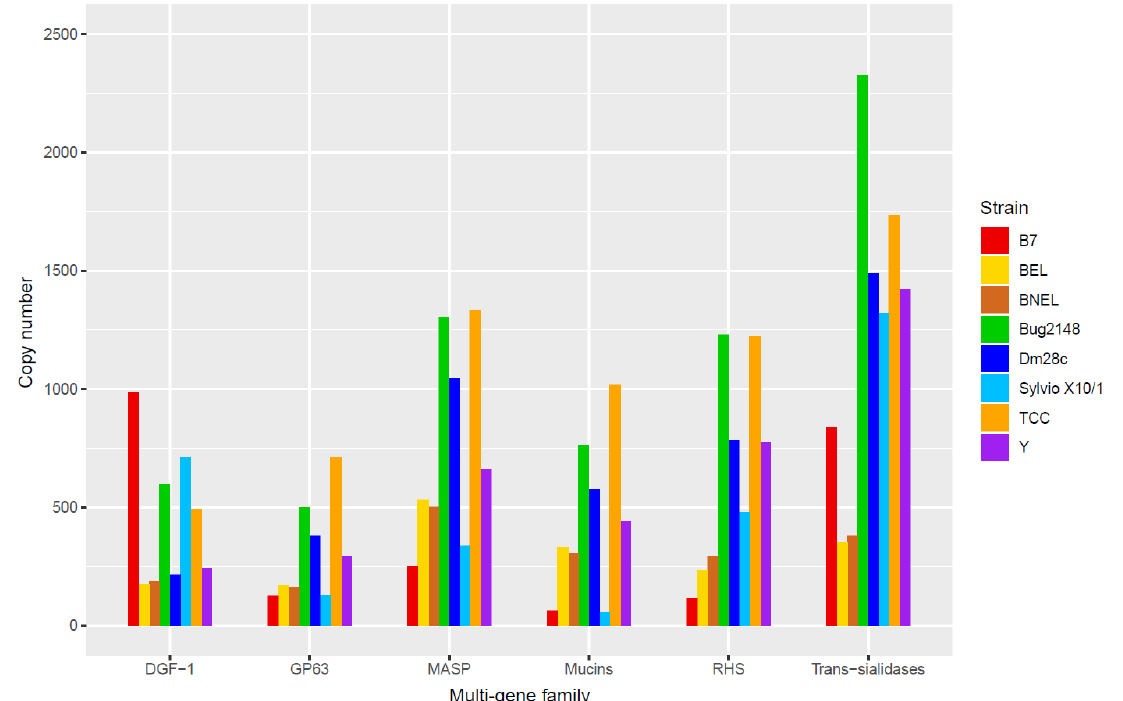
Figure 3. Genome copy number of the most abundant multi-gene families of T. cruzi and the B7 strain of T. cruzi marinkellei . BNEL: CL Brener Non-Esmeraldo-like; BEL: CL Brener Esmeraldo-like; DGF-1: Dispersed Gene Family 1; GP63: Glycoprotein 63; MASP: Mucin-Associated Surface Proteins; RHS: Retrotransposon Hot Spot